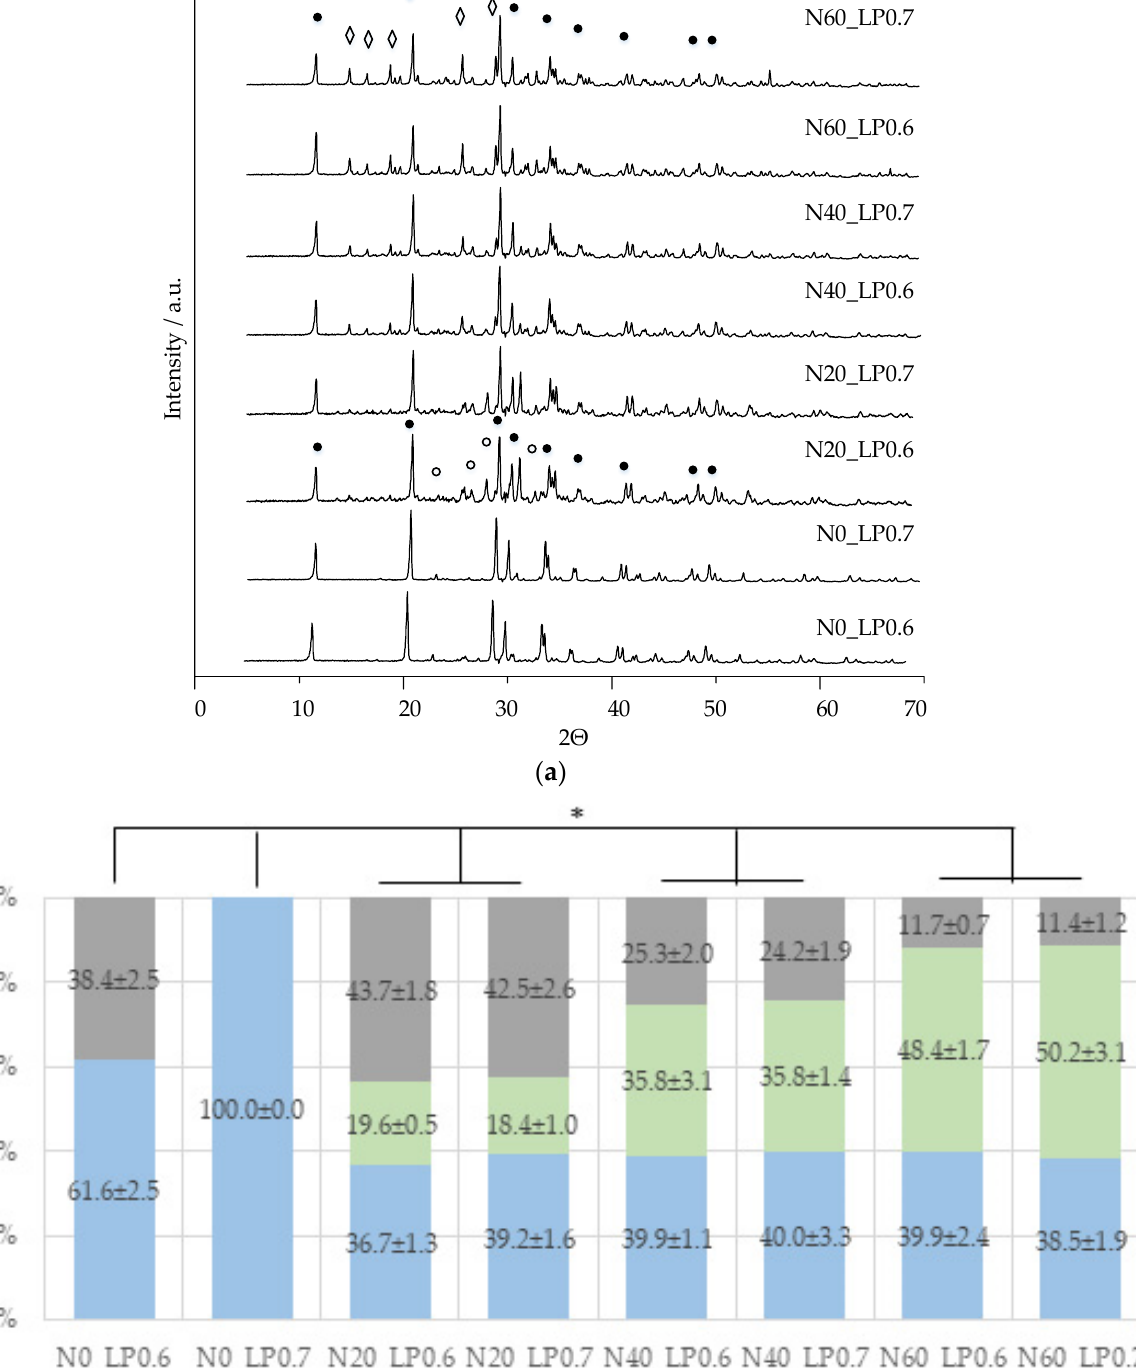
Figure 4. Diffractograms ( а ) and quantitative phase composition ( b ) of ceramics with SPP and CA: CaHPO 4 ·2H 2 O (brushite); CaHPO 4 (monetite). Significant differences are labeled with * ( p < 0.05).